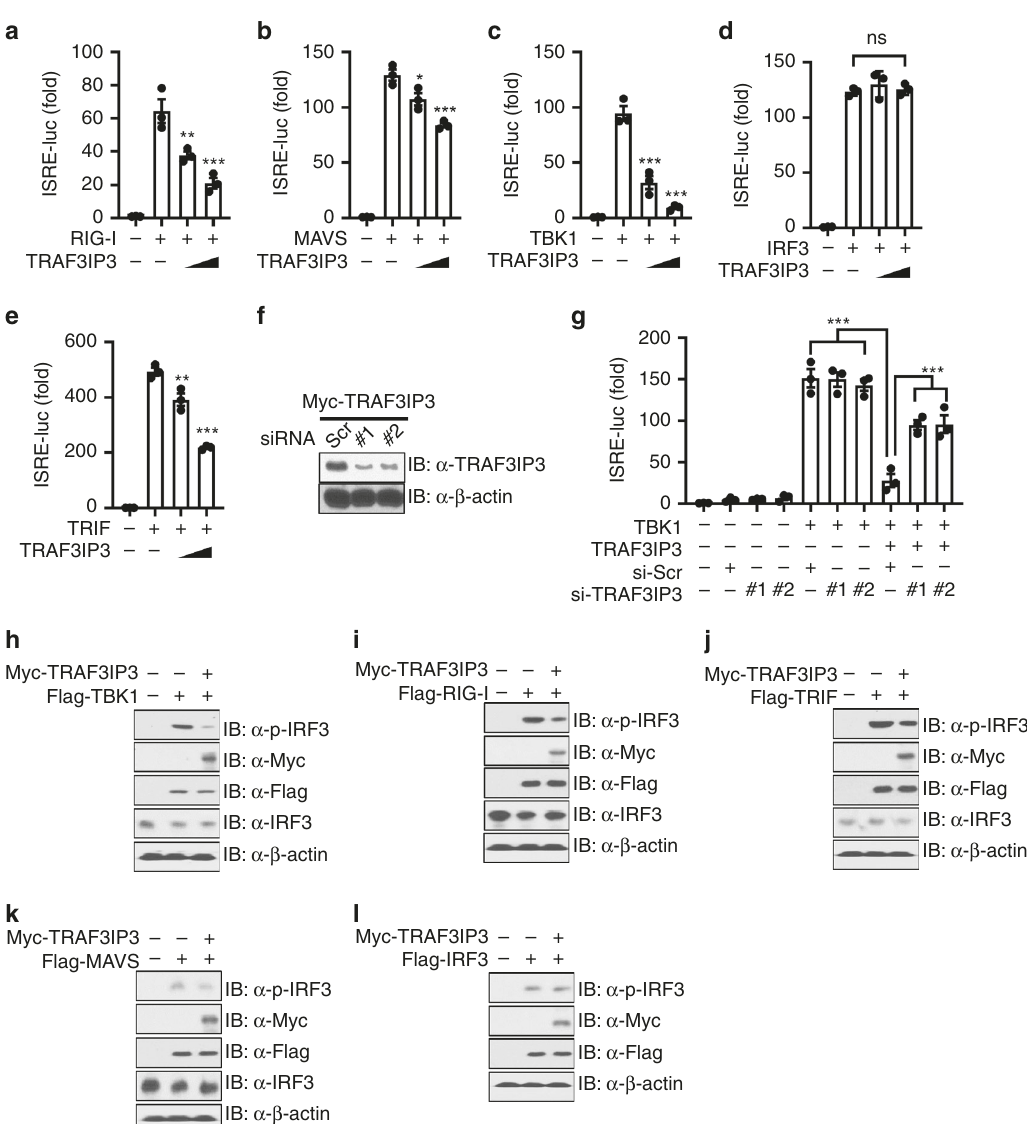
Traf3ip3 de fi cient mice are more resistant to VSV infection . To